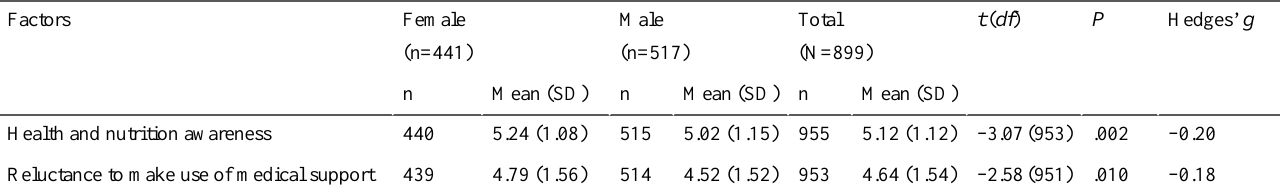
Table 4. Gender differences of weighted means of factor sum scores for attitudes influencing Internet health information searching on an aggregate